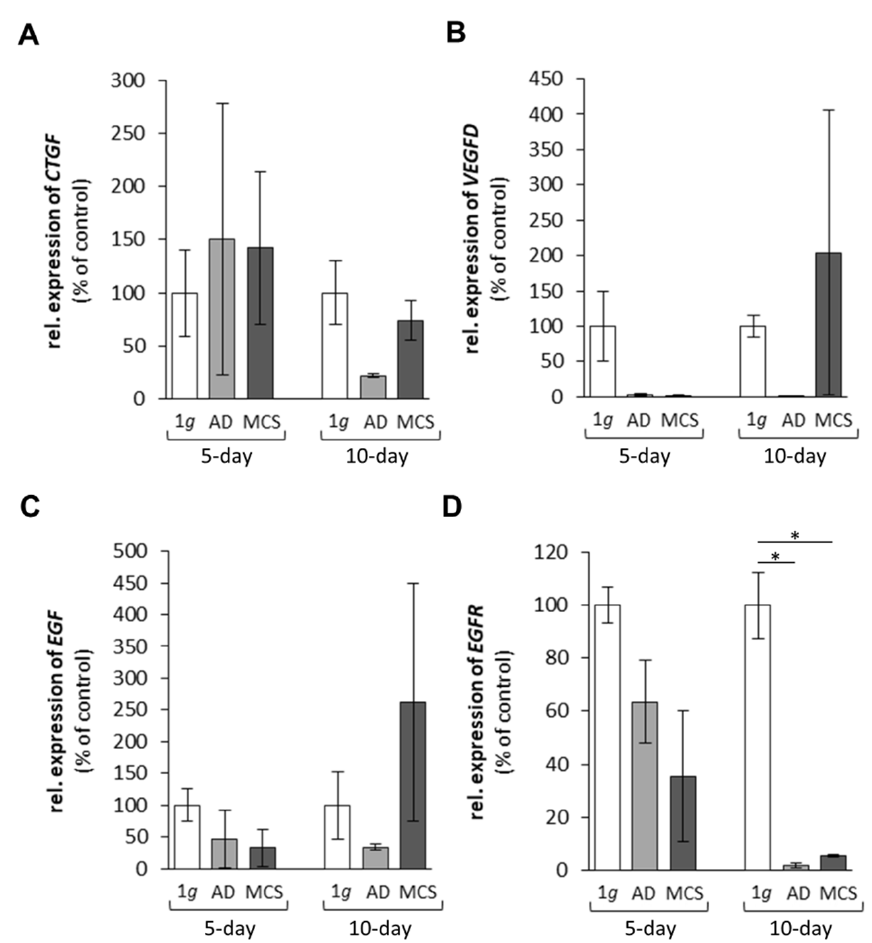
Figure 4. Gene expression of ( A ) CTGF , ( B ) VEGFD , ( C ) EGF and ( D ) EGFR of FTC-133 follicular thyroid cancer cells grown in space on the International Space Station for 5 and 10 days. * p < 0.05 versus 1 g ground control cells. Values are presented as the mean ± standard deviation in percent of 1 g ground controls, which was fixed as 100% for each condition. AD corresponds to adherent cells; MCS corresponds to multicellular spheroids. 5-day spaceflight/1 g ground control samples, n = 3; 10-day spaceflight samples/1 g ground control, n = 2.